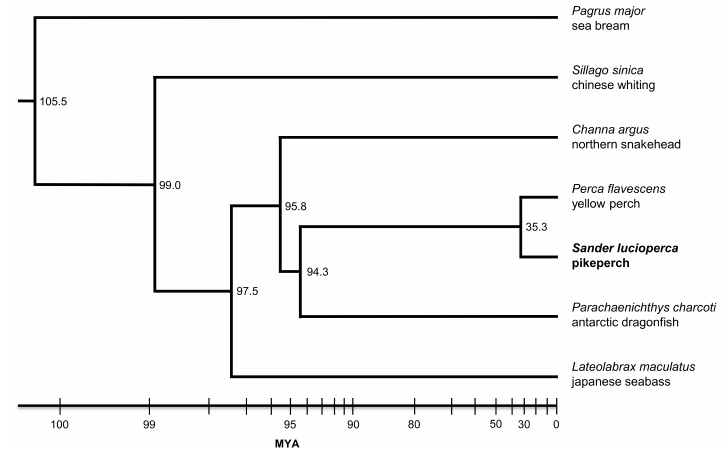
Figure 5. Phylogenetic analysis of Sander lucioperca and closely related Perciformes genomes. The constructed phylogenetic tree is based on one-to-one single-copy orthologs between the seven Perciformes fish species. The node labels indicate the estimated divergence time from the last common ancestor (LCA), in million years ago